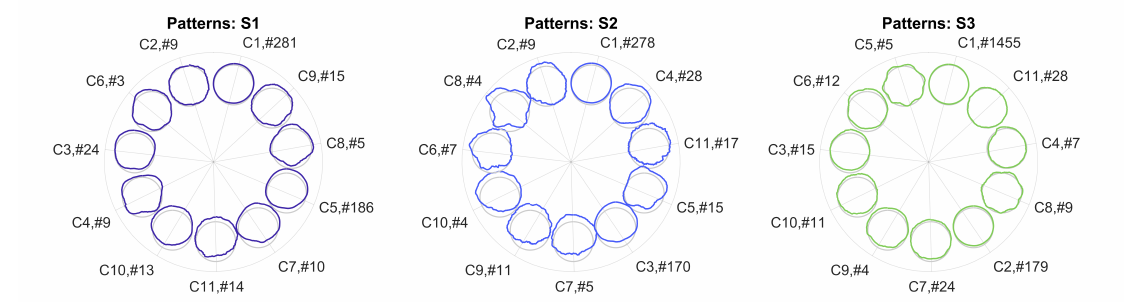
Figure 15. Morphing circle for sensors S 1, S 2, and S 3 and patterns C 1– C 11 each in av-acceleration.